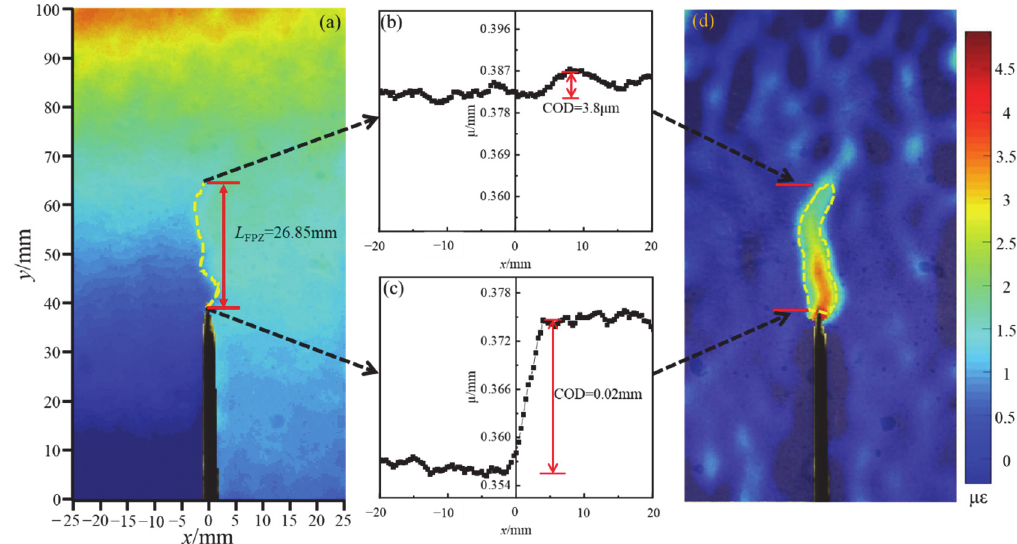
Figure 13. The BFAPC with 0.6% fiber content at strain rate of 10 − 6 s − 1 at peak load: ( a ) COD contour; ( b ) COD pattern at y = 40 mm; ( c ) COD pattern at y = 66.85 mm; and ( d ) strain contour.